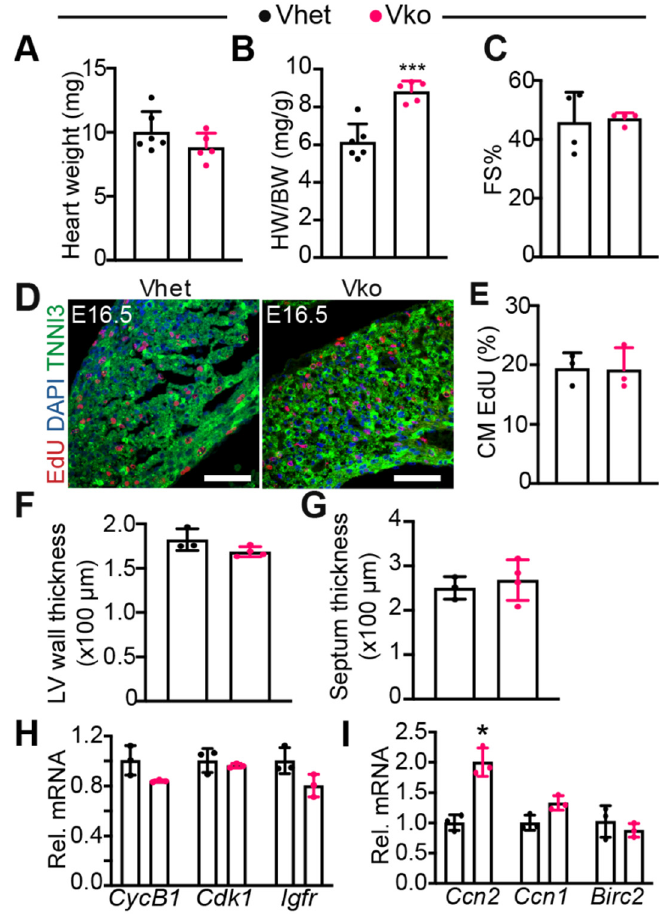
Figure 3. Loss of VGLL4 does not affect fetal myocardial growth: ( A ) heart weight; ( B ) heart-to-body weight ratio ( A , B ), n = 5–6; ( C ) echocardiography measurement of heart function at P0. FS%, fraction shortening. N = 4; ( D ) representative immunofluorescence images of E16.5 myocardium. Scale bar = 50 µm; ( E ) cardiomyocyte (CM) EdU incorporation rate. N = 3; ( F , G ) measurement of left ventricle free wall thickness ( F ) and septum thickness ( G ); ( H , I ) qRT-PCR measurement of cell proliferation-related genes ( H ) and YAP/TEAD target genes ( I ). Total RNA extracted from E16.5 myocardium was used for qRT-PCR. mRNA levels were normalized to Gapdh . Student’s t -test: * p < 0.05. N = 3.